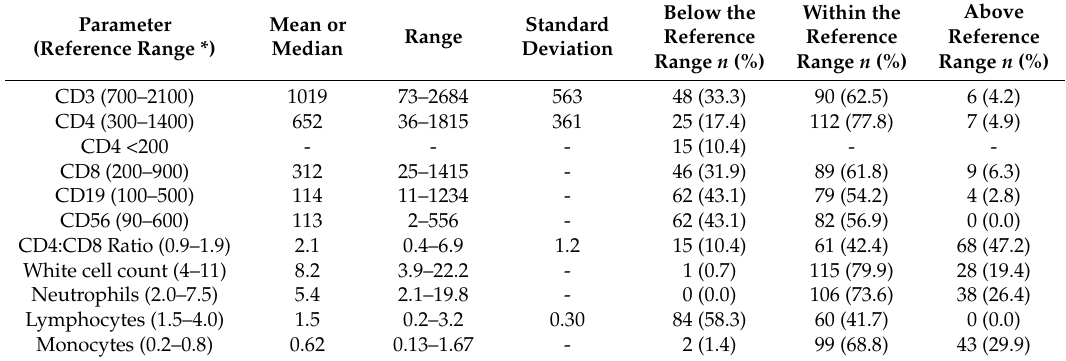
Table 3. Summary of results of CDs, total and differential white cell count parameters.